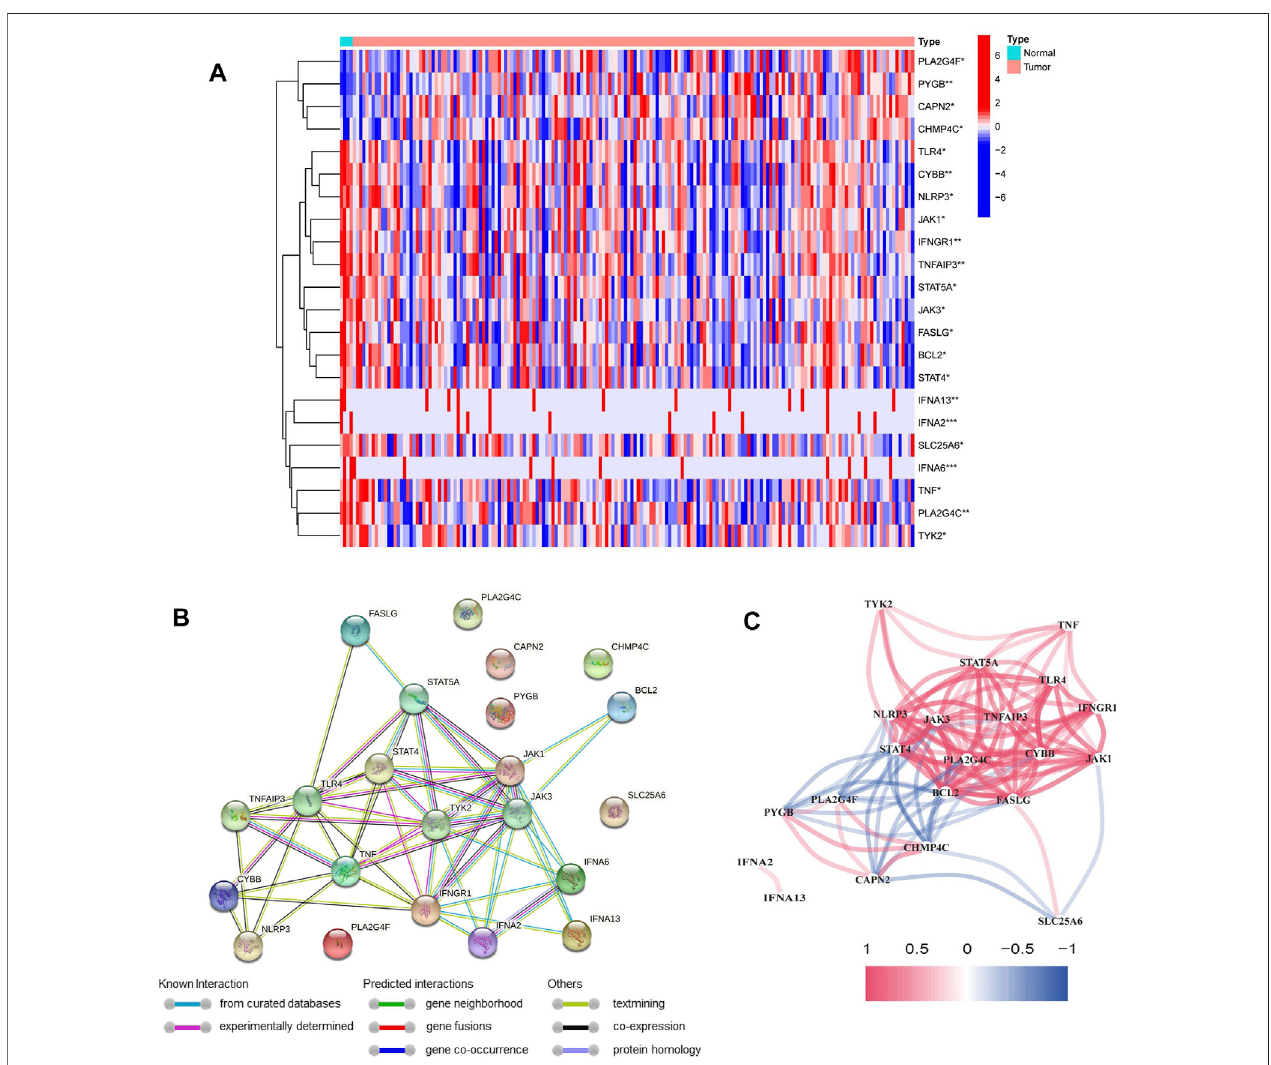
FIGURE 2 | Identi fi cation of differentially expressed NRGs in the TCGA cohort. (A) Heatmap of differentially expressed NRGs between normal samples and PDAC samples(* p < 0.05,** p < 0.01,*** p < 0.001). (B) ThePPInetworkofdifferentiallyexpressedNRGs. (C) ThecorrelationnetworkofdifferentiallyexpressedNRGs(redline: positive correlation; blue line: negative